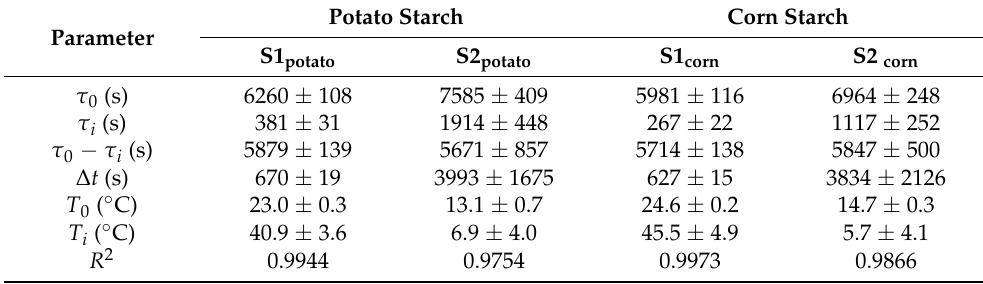
Table 1. Values of the parameters in the Equations (1) and (2) as result of the experimental data fitting. Potato Starch Corn Starch Parameter S1 potato S2 potato S1 corn S2 corn τ 0